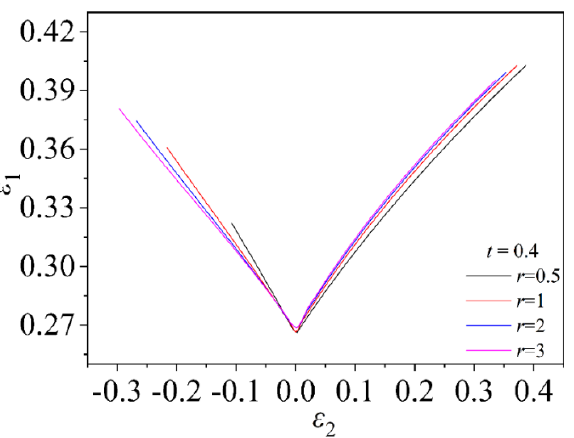
Figure 17. FLD for different r values based on C-H instability criterion and Hill48 yield criterion at t = 0.